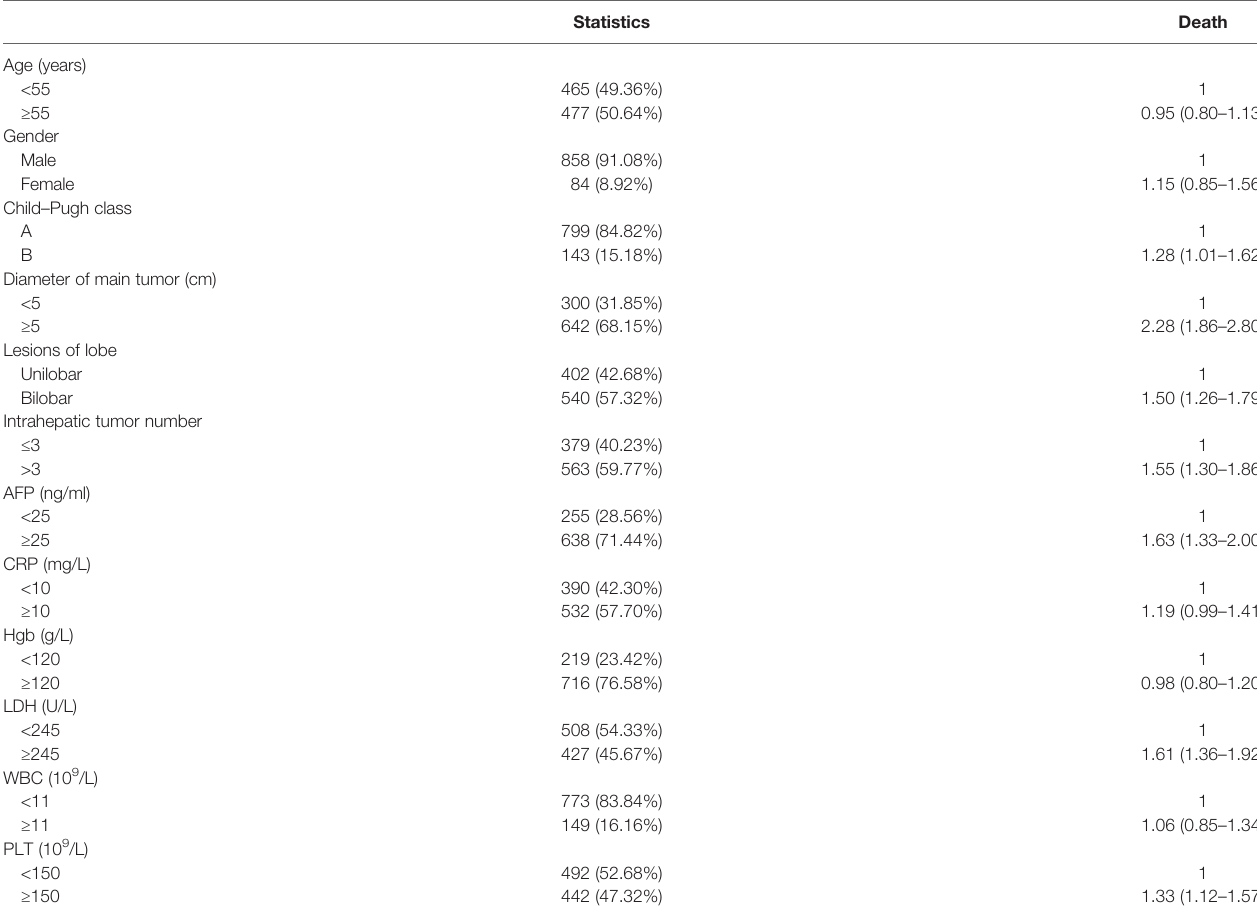
TABLE 2 | Univariate analysis of prognostic factors in the derivation cohort.